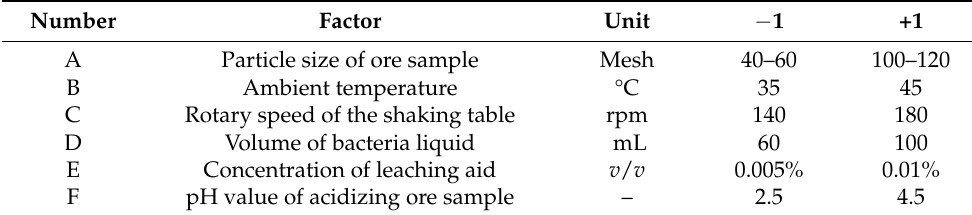
Table 1. Two levels of each